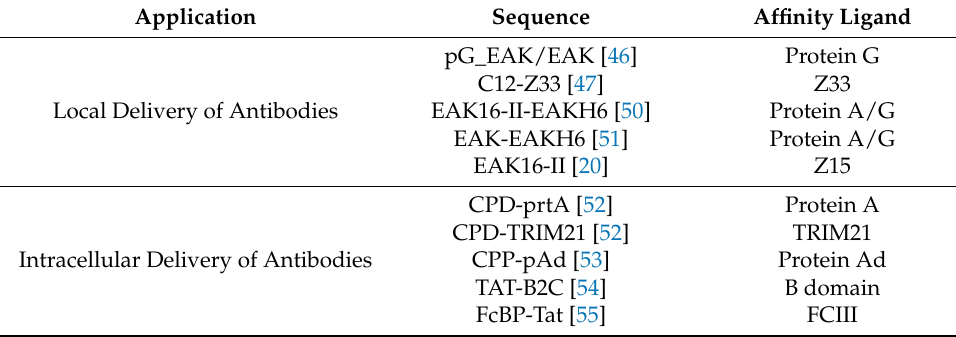
Table 2. Antibody Delivery by Different Peptide Sequences.